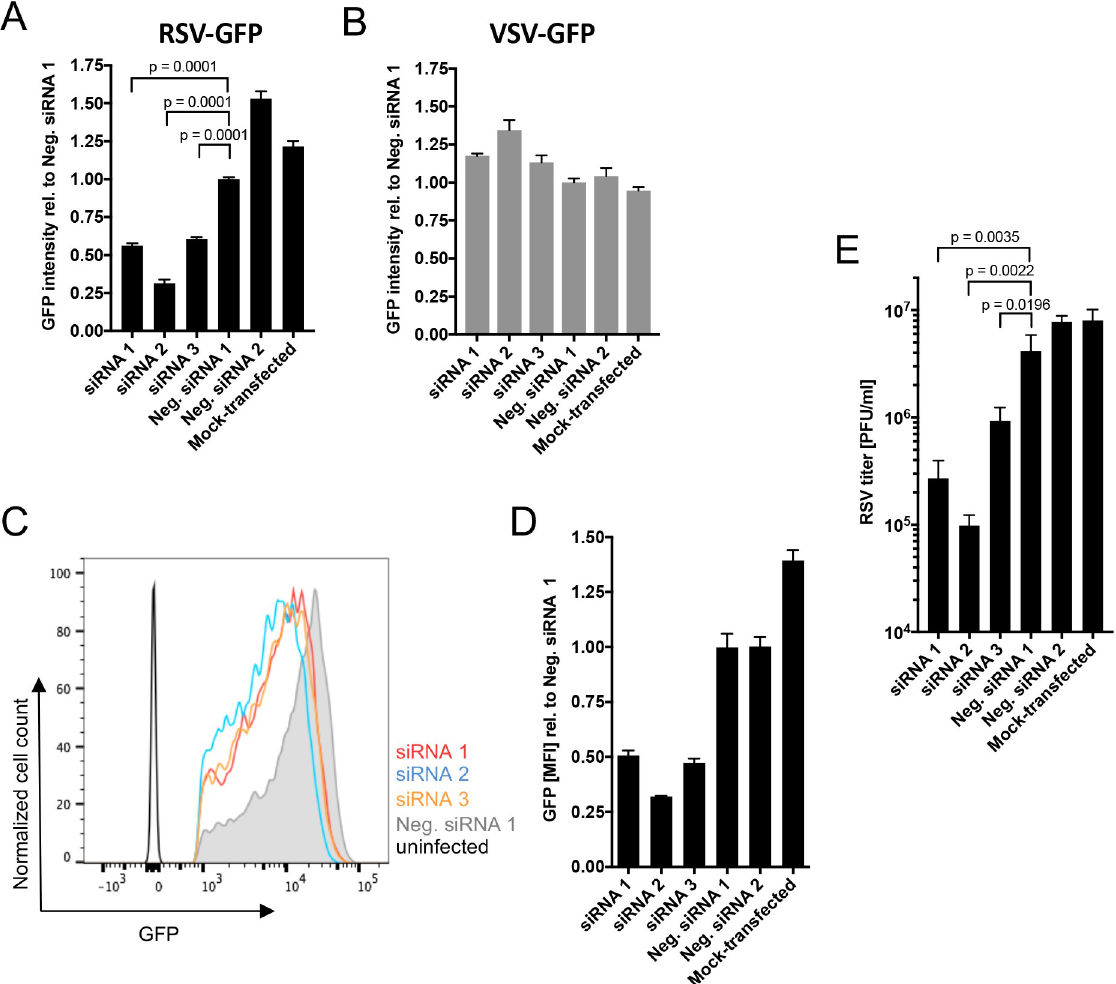
Fig 2. Effect of ATP1A1 knockdown on infection by RSV-GFP (A, C, D) and VSV-GFP (B). A549 cells were transfected with the indicated siRNAs and 48 h later were infected with 1 PFU/cell RSV-GFP (A, C, D) or 0.5 PFU/cell VSV-GFP (B). (A and B) Effects on RSV and VSV . Following infection with RSV-GFP (A) or VSV-GFP (B), the cells were incubated for 17 h, and the GFP intensity of the total area of each well of A549 cells was quantified by scanning with an ELISA reader and is expressed relative to cells infected with the same virus for which the transfected siRNA was Neg. siRNA 1. (C and D) Flow cytometry analysis of RSV-GFP expression. Following infection with RSV-GFP, the cells were incubated for 24 h, and GFP expression of single, live, GFP + cells was quantified by flow cytometry, with cells from an untransfected, uninfected well included for reference. The plot (C) shows cell count versus GFP intensity, and the histogram (D) shows GFP MFI relative to cells infected with the same virus for which the transfected siRNA was Neg. siRNA 1. (E) Titer of progeny RSV-GFP. Following infection with RSV-GFP (MOI = 1 PFU/cell), the cells were incubated for 24 h, and the cells and media were harvested together (Materials and Methods) and the yield of RSV-GFP was determined by plaque titration on Vero cells. All data in A-D are derived from at least three independent experiments and shown as mean values with error bars indicating the standard deviation. The statistical significance of difference was determined by one-way analysis of variance with Dunnett’s multiple comparison post-test and p-values are shown for each